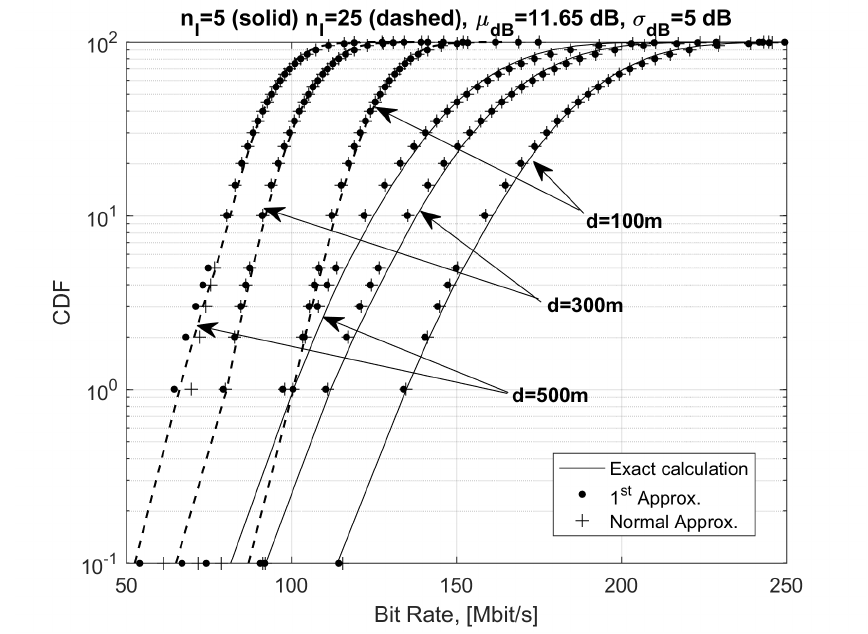
Figure 4. Cumulative distribution function (CDF) of the bit rate for variable distance d and n I = 5, 25.